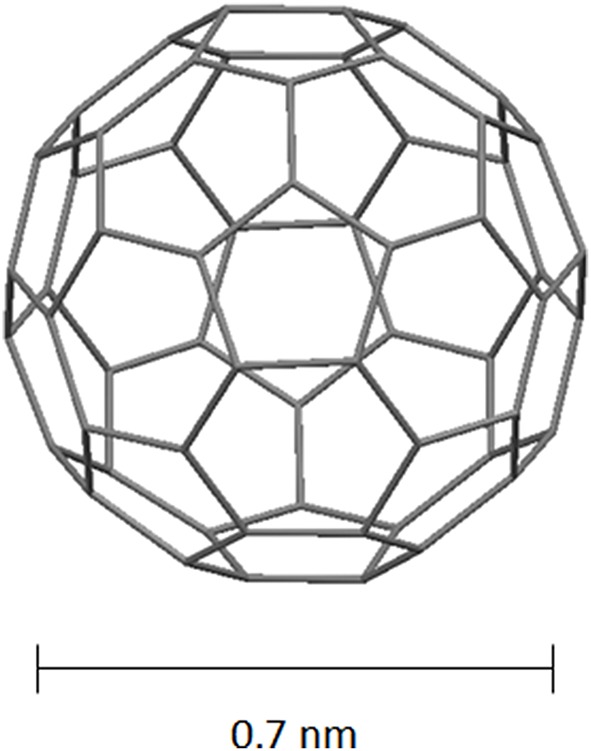
Schematic representation of C60 fullerene.